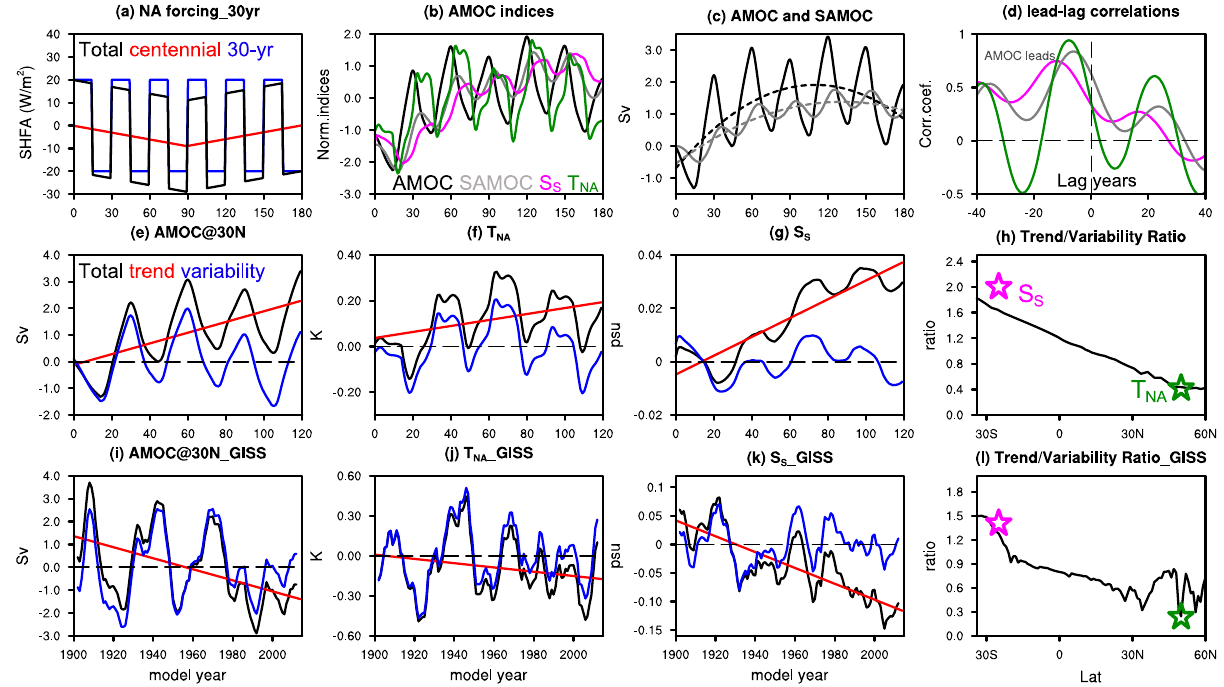
Fig. 5 | Trend-signal/variability-noise ratio of Atlantic meridional overturning circulation (AMOC) indices. a – h Demonstrate the results from an ocean general circulation model (OGCM) experiment : a Surface heat fl ux forcing applied in the North Atlantic (black) which consists of two signals: 30-years variability signal (blue) and centennial trend signal (red). b Normalized anomaly of the AMOC at 30°N (black), AMOC at 30°S (gray), warming hole fi ngerprint T NA (green) and salinity-based fi ngerprint S S (magenta). Anomalies are relative to the correspond- ing control experiment. c Anomaly of the northern and southern AMOCs. Also